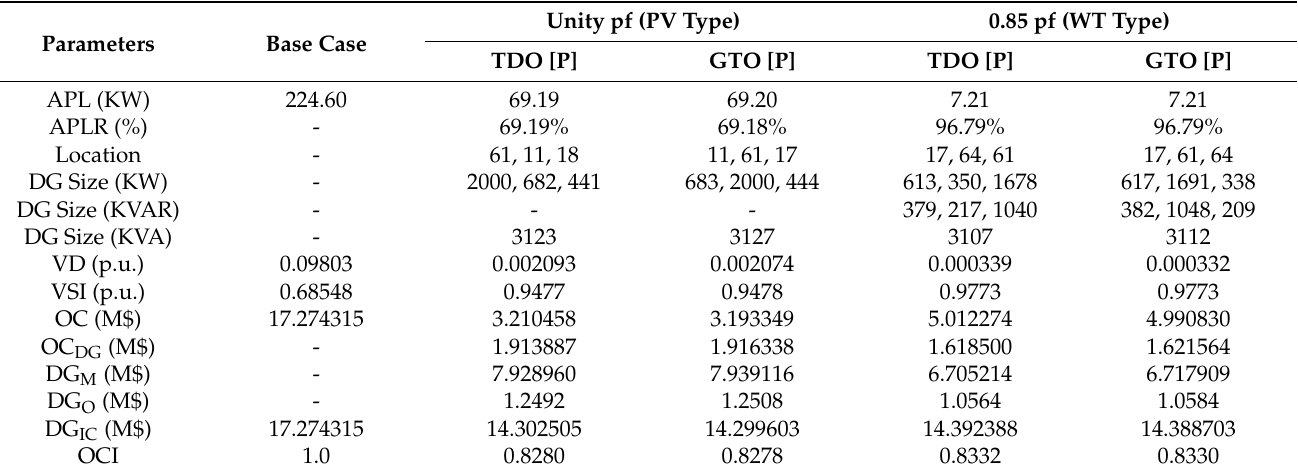
Table 15. Results of OADG for a 69-bus RDN for MOF at unity pf (PV Type) and 0.85 pf (WT type) in a CP load